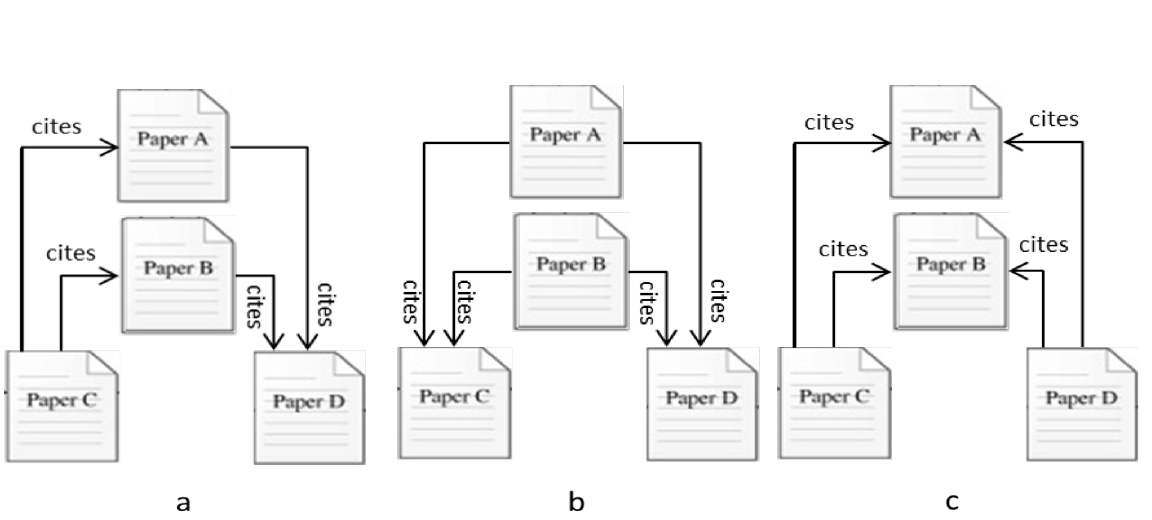
Figure 3. Citation relationship (a), Co-citation relationship (b) and Bibliographic